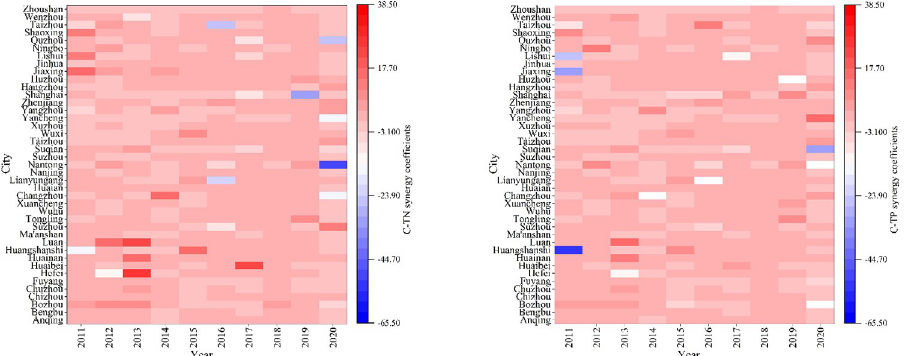
Fig 3. Characteristics of synergistic effect of TN/TP and carbon reduction in